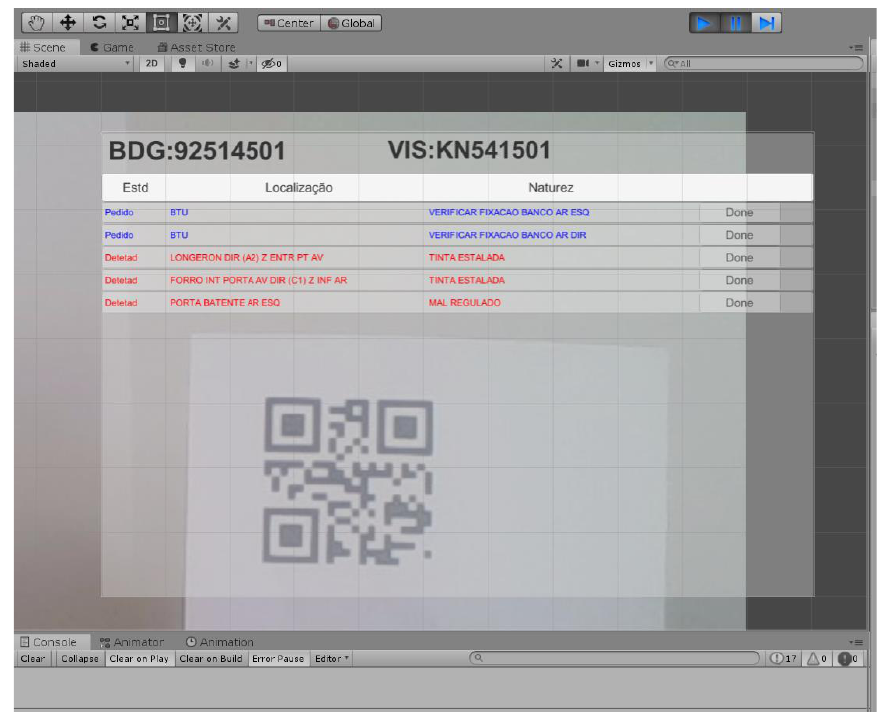
Figure 6. Screenshot of the system execution on the Windows platform.